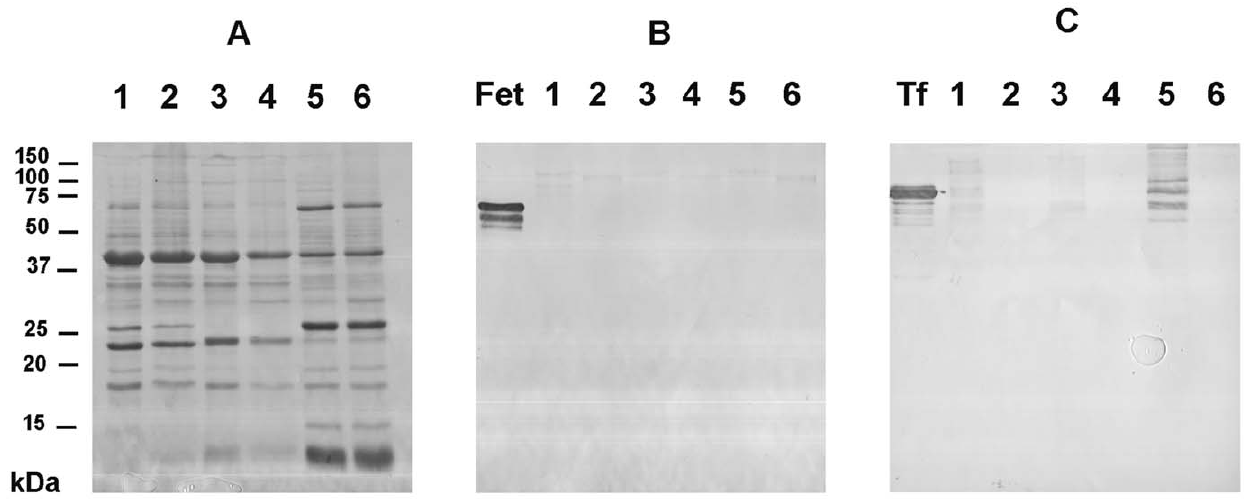
Figure 2. Glycopattern analysis of proteins extracted from skinned biopsies comparing with contractile proteins and whole proteins extracts. Soleus contractile proteins (lanes 1 and 2), proteins extracted from skinned biopsies (lanes 3 and 4) and whole proteins extracted from soleus (lanes 5 and 6) were separated on 12.5% SDS-PAGE and transferred onto nitrocellulose sheet for western blot analysis. Lanes 2, 4 and 6 corresponds to PNGaseF-treated proteins. (A) corresponds to Ponceau staining, (B) to AP-revelation for MAA binding on glycoproteins, (C) to AP- revelation of SNA binding on glycoproteins. Fet (fetuin) and Tf (transferin) correspond to positive glycoprotein markers.